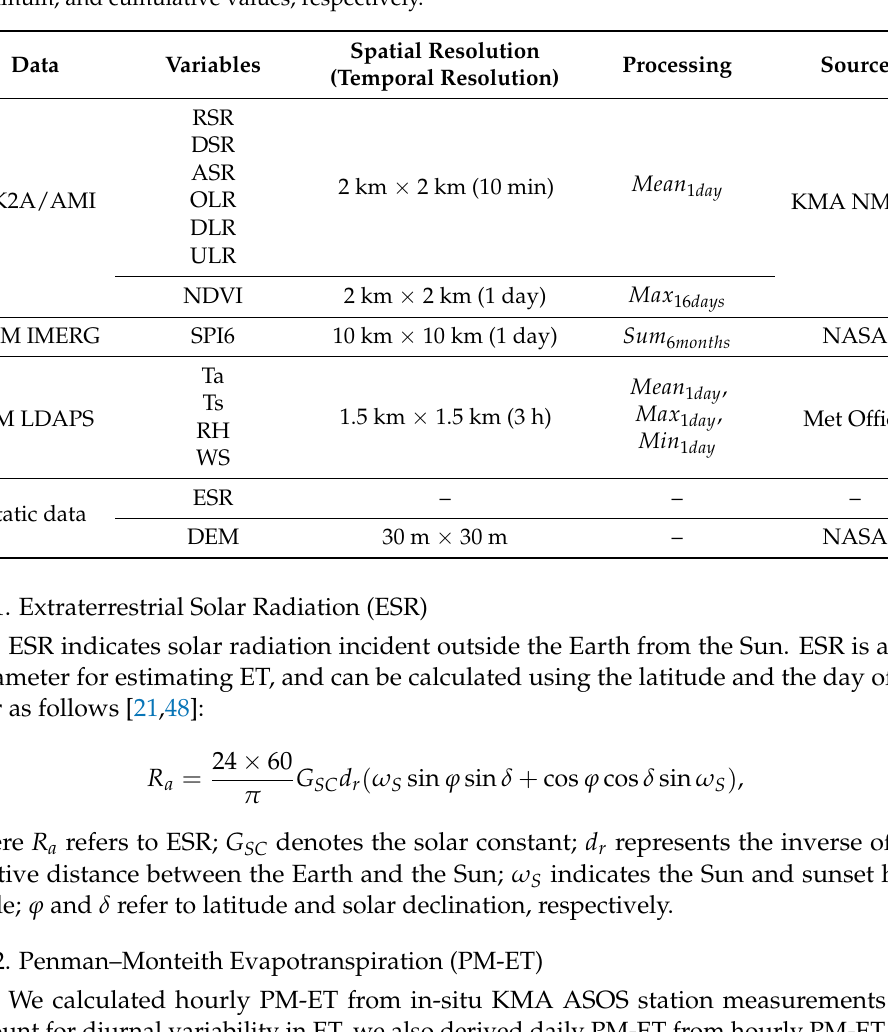
Table 2. Spatial and temporal resolution, processing method, and input data source for the artificial neural network (ANN) model, where Mean, Max, Min, and Sum indicate average, maximum, minimum, and cumulative values,